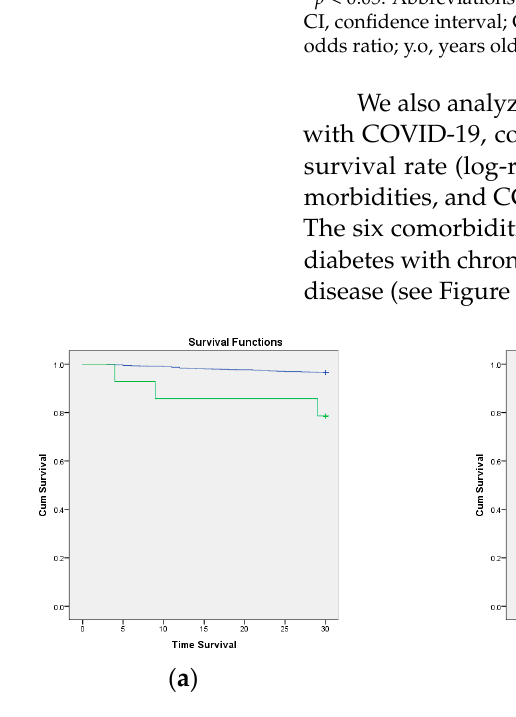
Figure 1. Kaplan–Meier curve of the 30-day survival rate according to COVID-19 status, CCI score, and comorbidities. The green line is patients who have that variable, and the blue line is patients without that variable. ( a ) COVID-19 status (log-rank p ≤ 0.01; ( b ) comorbidities (log-rank p ≤ 0.01); and ( c ) CCI > 3 (log-rank p ≤ 0.01).